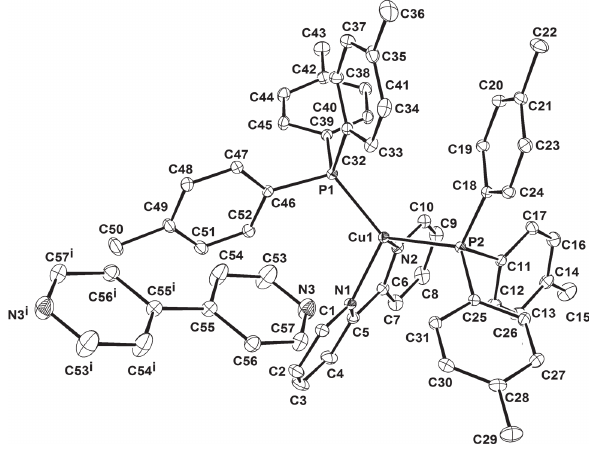
Table 1: Data collection and